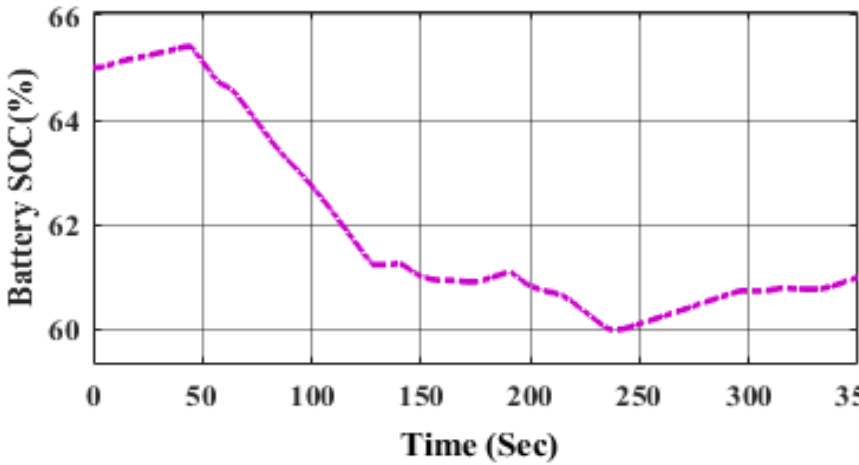
Figure 21. Time response of battery current.